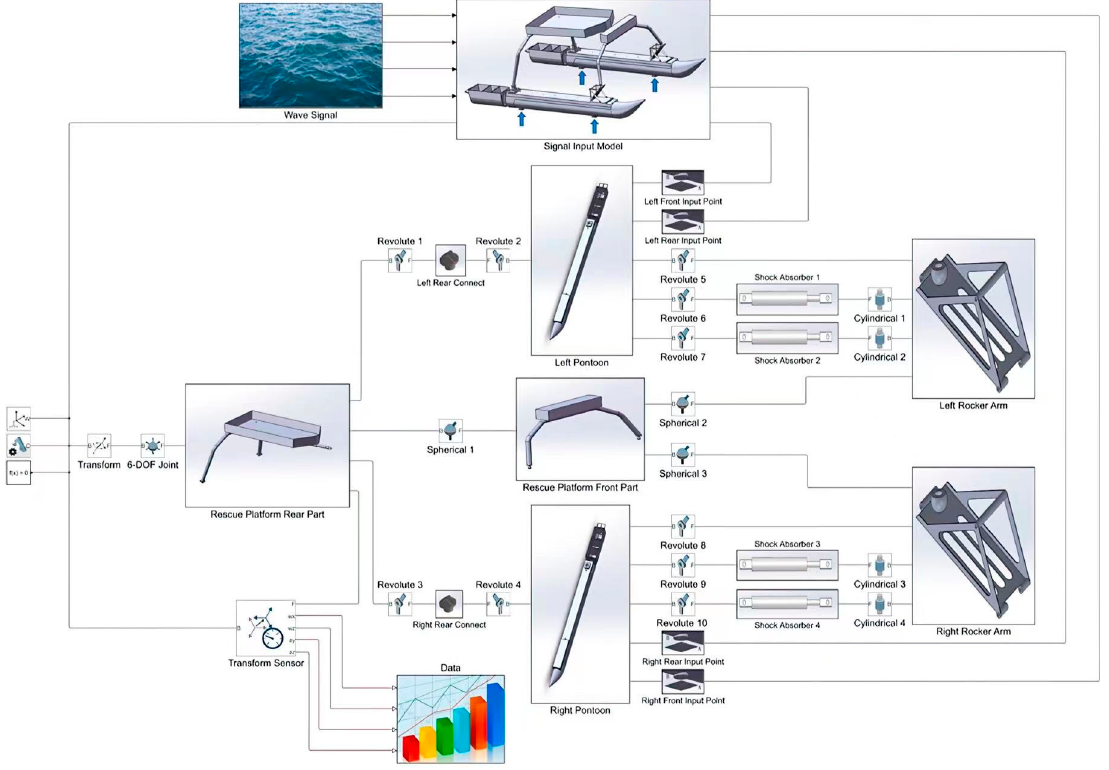
Figure 6. Block diagram model of the rescue vessel.